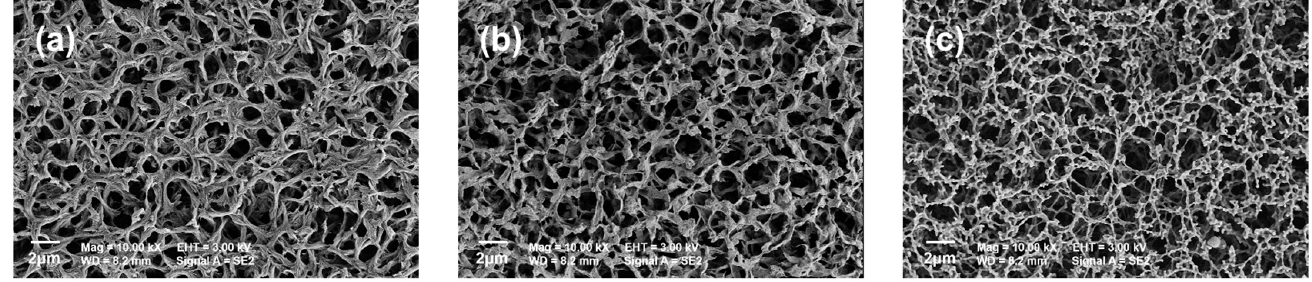
Figure 6. SEM image of the surface morphology of the PA MFMs ( a ), PVDF MFMs ( b ), NC MFMs ( c